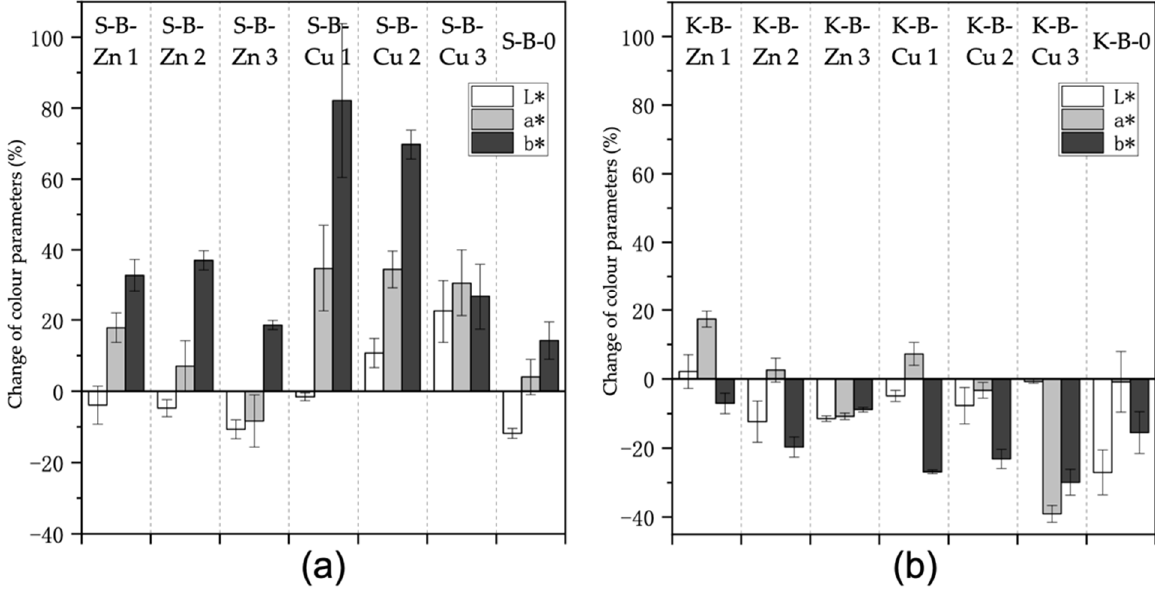
Figure 11. The change in colour parameters values of 120-day-exposed samples: ( a ) Sugi groups; ( b ) Keyaki groups ( n = 3).